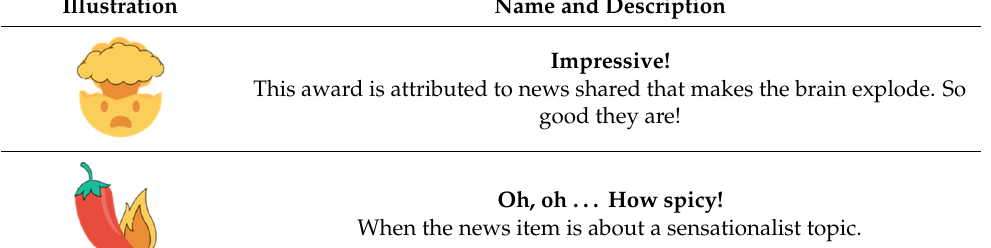
Table 3. Description of the awards. Retrieved from Gamifying News for the miOne Online Community (Regalado 2021).